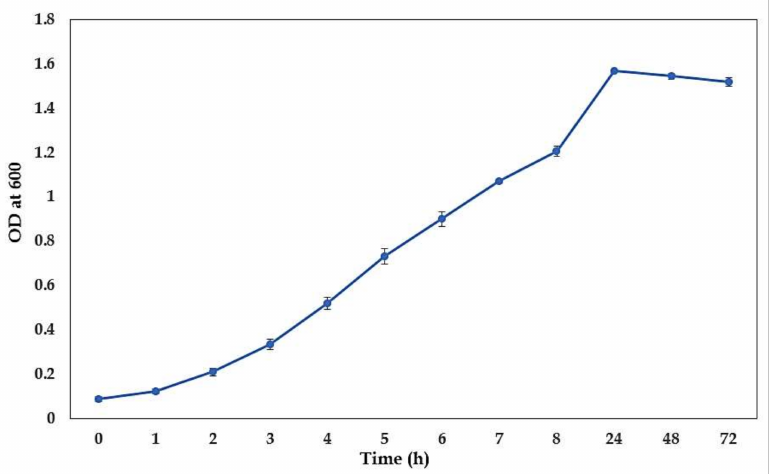
Figure 1. Growth curve of C. albicans in SDB at 35 ◦